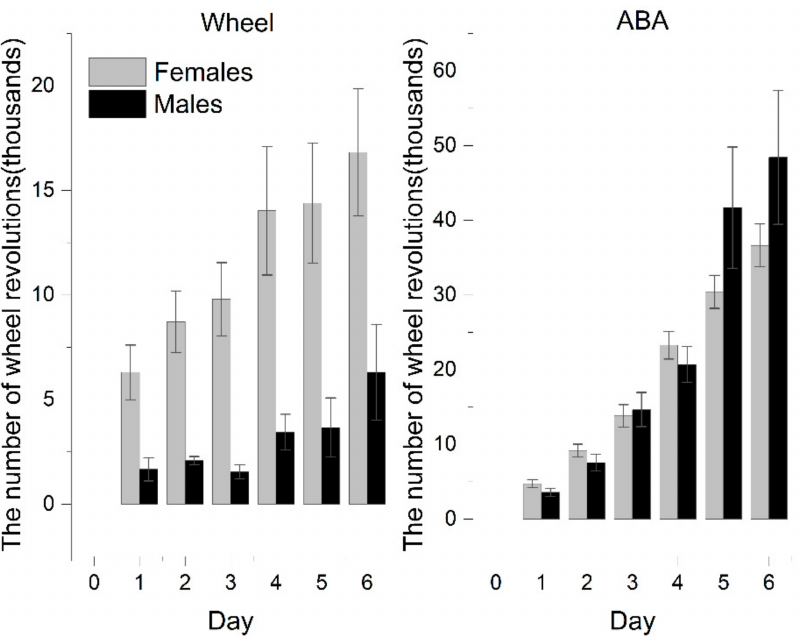
Figure 3. Physical activity of female and male rats in the wheel (Wh; n = 21) group and activity-based anorexia (ABA; n = 42)